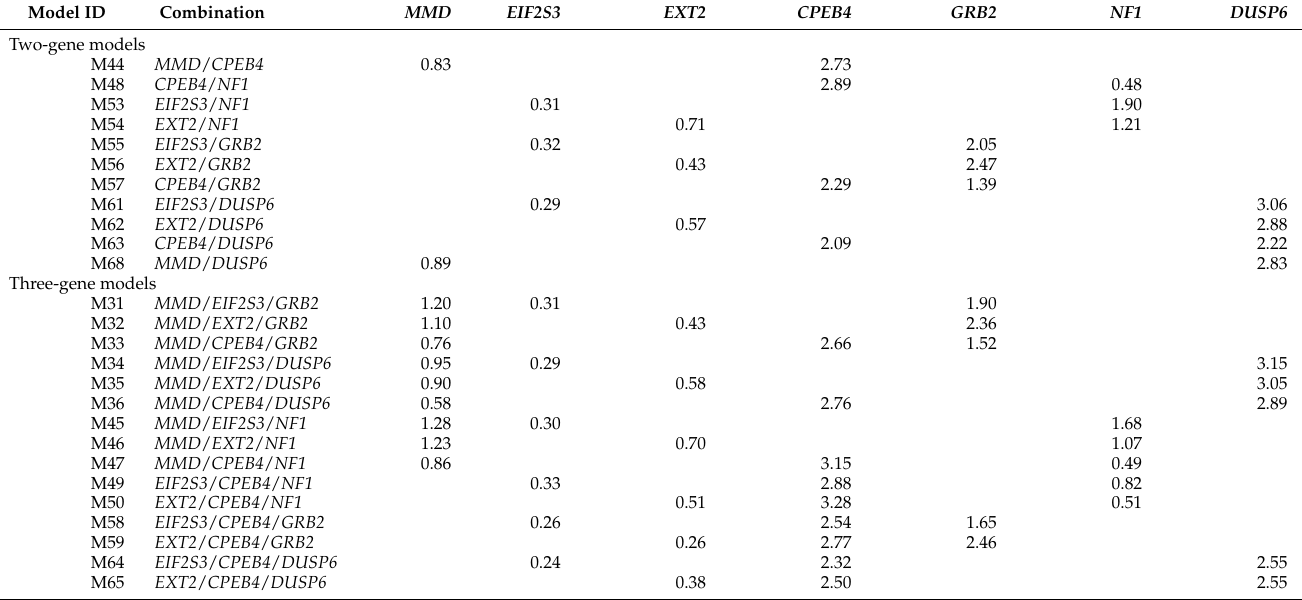
Table 6. Logistic analysis for gene–gene interactions. Odds ratios (ORs) of each gene for each two-gene or three-gene model are